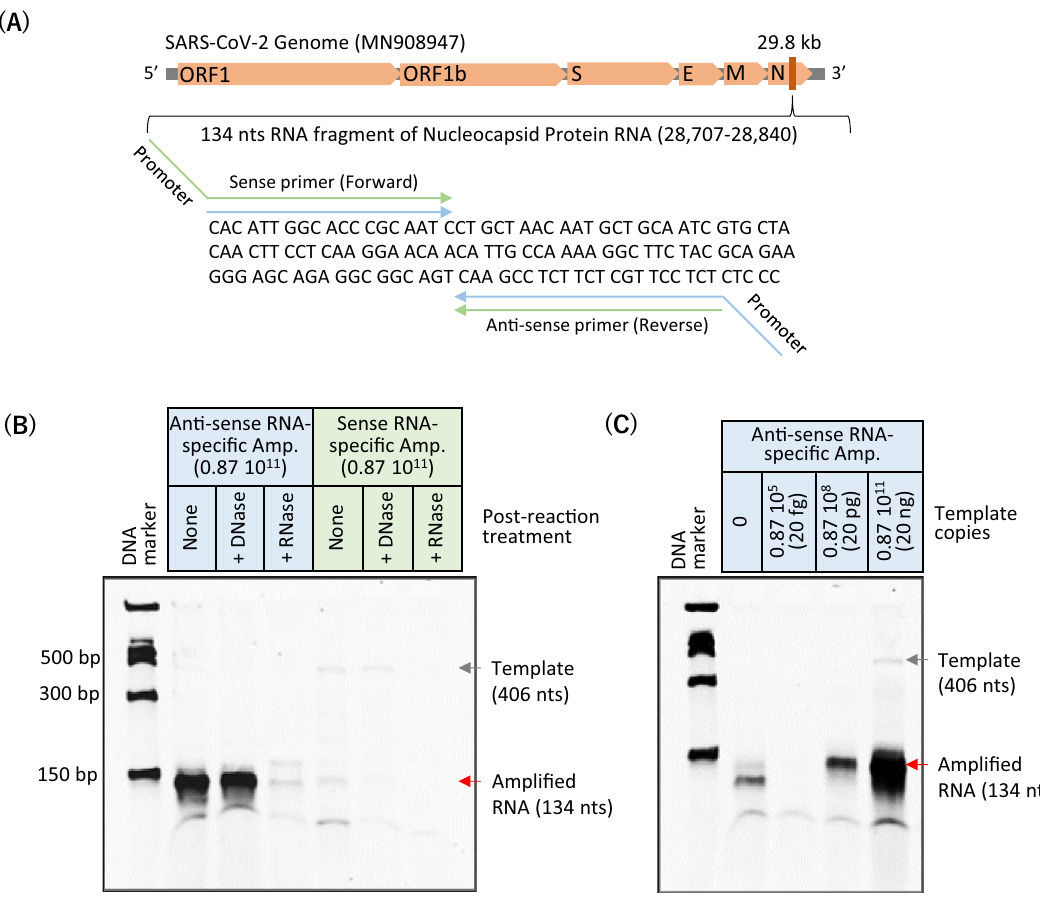
Figure 3. Evaluation of the specificity of RNA-specific amplification of sense or antisense strands of SARS- CoV-2 RNA. ( A ) Structure of the SARS-CoV-2 genome and a target sequence for amplification. The sequence to which primers bind is indicated by arrows. ( B ) Electrophoretic analysis of RNA-specific amplification of antisense or sense strands in 10 min. The desired amplified product (134 nt RNA) is shown by the red arrow and clearly observed with the amplification of the antisense strand of RNA. RNA-specific amplicons were confirmed by postreaction treatment with RNase-free DNase or RNase (RNase ONE and RNase H). ( C ) Electrophoretic analysis for evaluating the detection limit of RNA-specific amplification using SARS-CoV-2 RNA template at a level ranging from 10 11 to 10 5 and a zero copy number with a reaction incubation time of 10